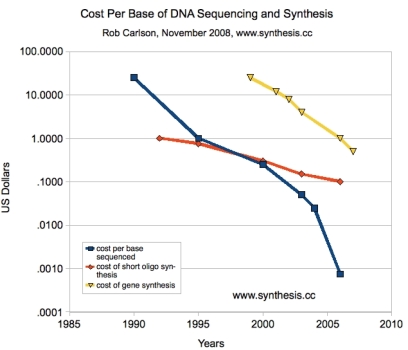
Carlson curves [15].